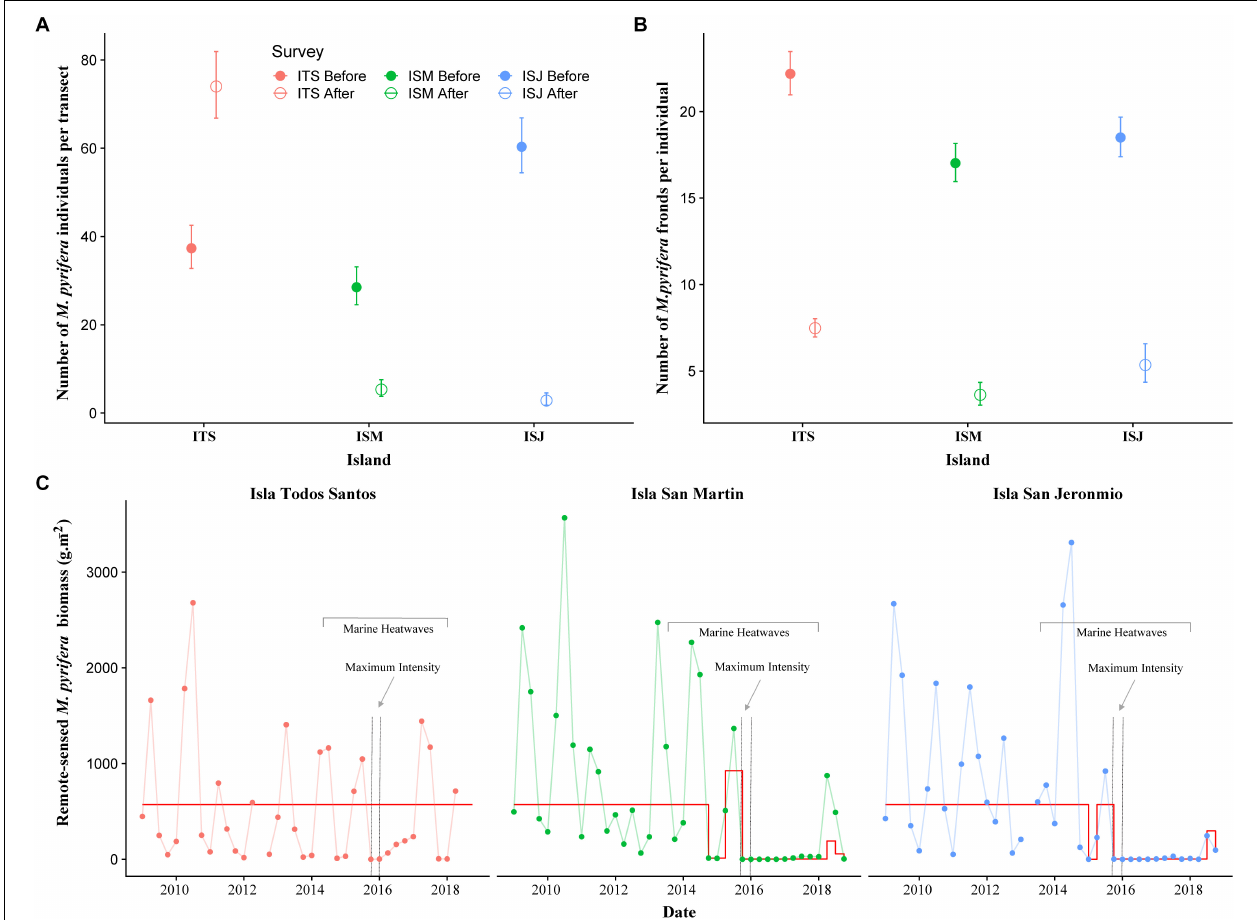
Table 1 . (C) Time series of remote-sensed kelp seasonal mean biomass (g.m − 2 ) at each island. Superimposed on each time series (in red) is the estimated deviation from the expectation of an ARIMA (0,1,1) model fitted to the log 10 (x + 1) transformed biomass data (deviations were back-transformed to the original scale). Dotted gray lines represent the duration of the MHW with the maximum intensity registered at each island during the 2013–2017 MHWs.